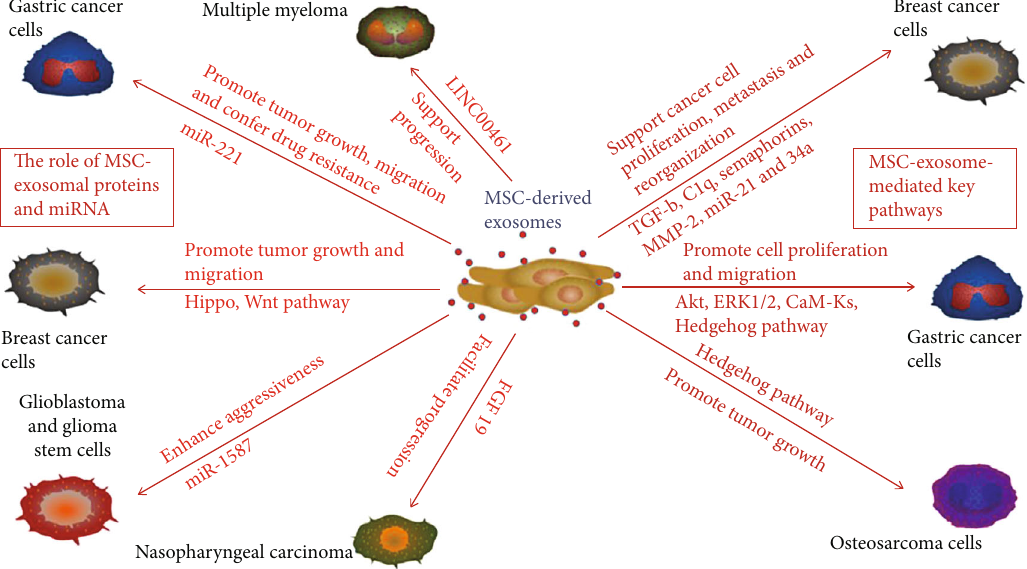
Figure 2: Promotional roles of MSC-derived exosomes in tumors. MSC-derived exosomes can promote tumor growth and cell migration and confer drug resistance on gastric cancer by activating the Akt, ERK1/2, CaM-Ks, and Hedgehog pathways and transporting miR-221 to cancer cells. MSC-derived exosomes support multiple myeloma progression by shuttling LINC00461. Moreover, MSC-derived exosomes support breast cancer cell proliferation, metastasis, and reorganization through Hippo and Wnt pathways and by delivering exosomal TGF-b, C1q, semaphorins, MMP-2, miR-21, and miR-34a. MSC-derived exosomes promote osteosarcoma growth through the Hedgehog pathway. MSC-derived exosomes facilitate nasopharyngeal carcinoma progression through the delivery of FGF19. MSC-derived exosomes enhance the aggressiveness of glioblastoma and growth of glioma stem cells through the delivery of